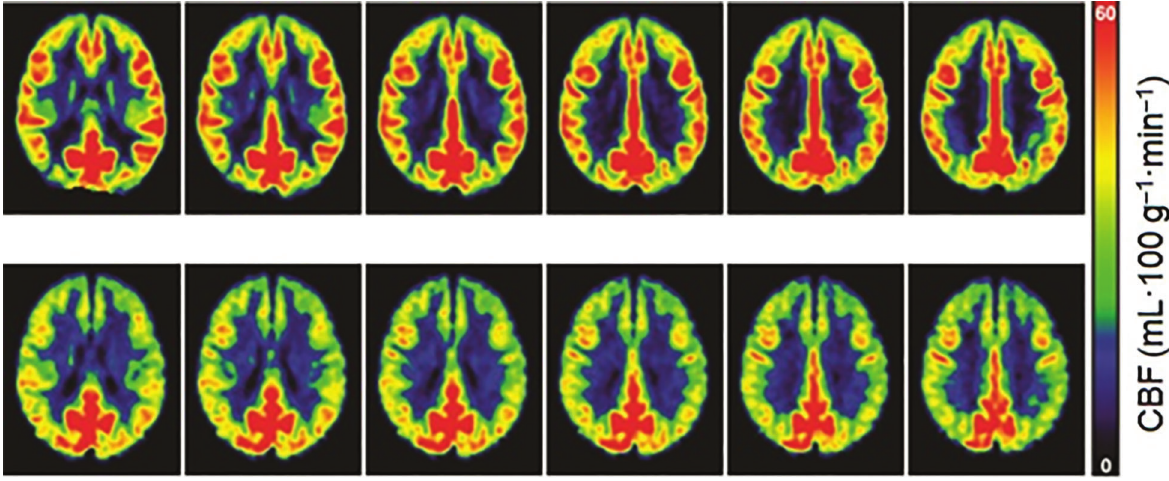
Figure 3. Averaged normocapnic cerebral blood fl ow (CBF) maps for young (upper row) and elderly healthy adults (bottom row).